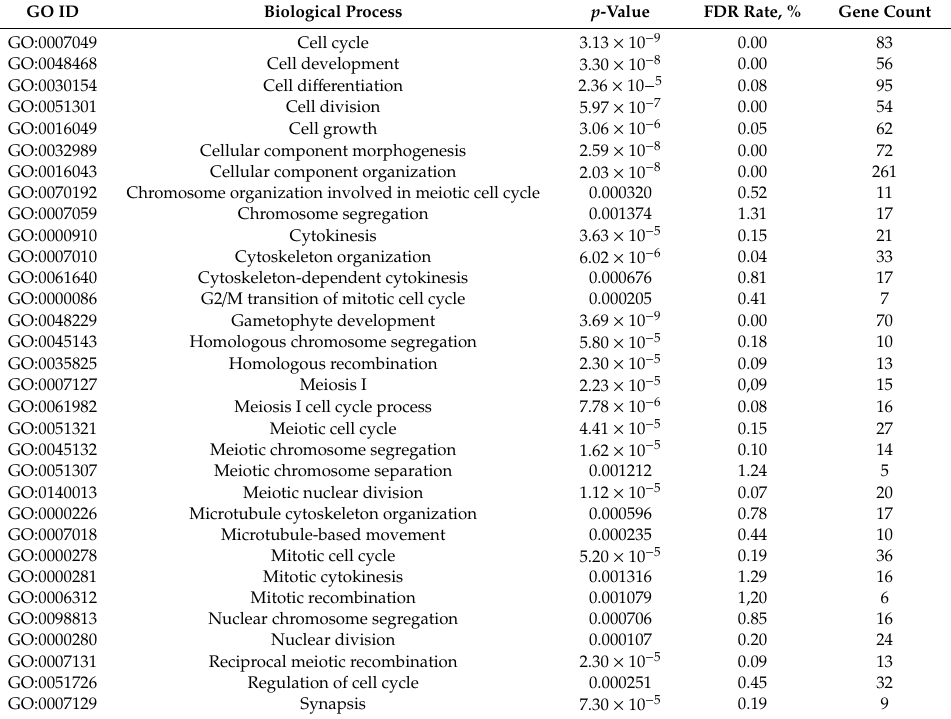
Table 2. Assignment of di ff erentially expressed downregulated genes in knl2 flower buds to di ff erent functional categories related to cell processes. Gene Ontologies were analyzed for term enrichment using the Generic Gene Ontology GO::TermFinder tool (cuto ff of 5%